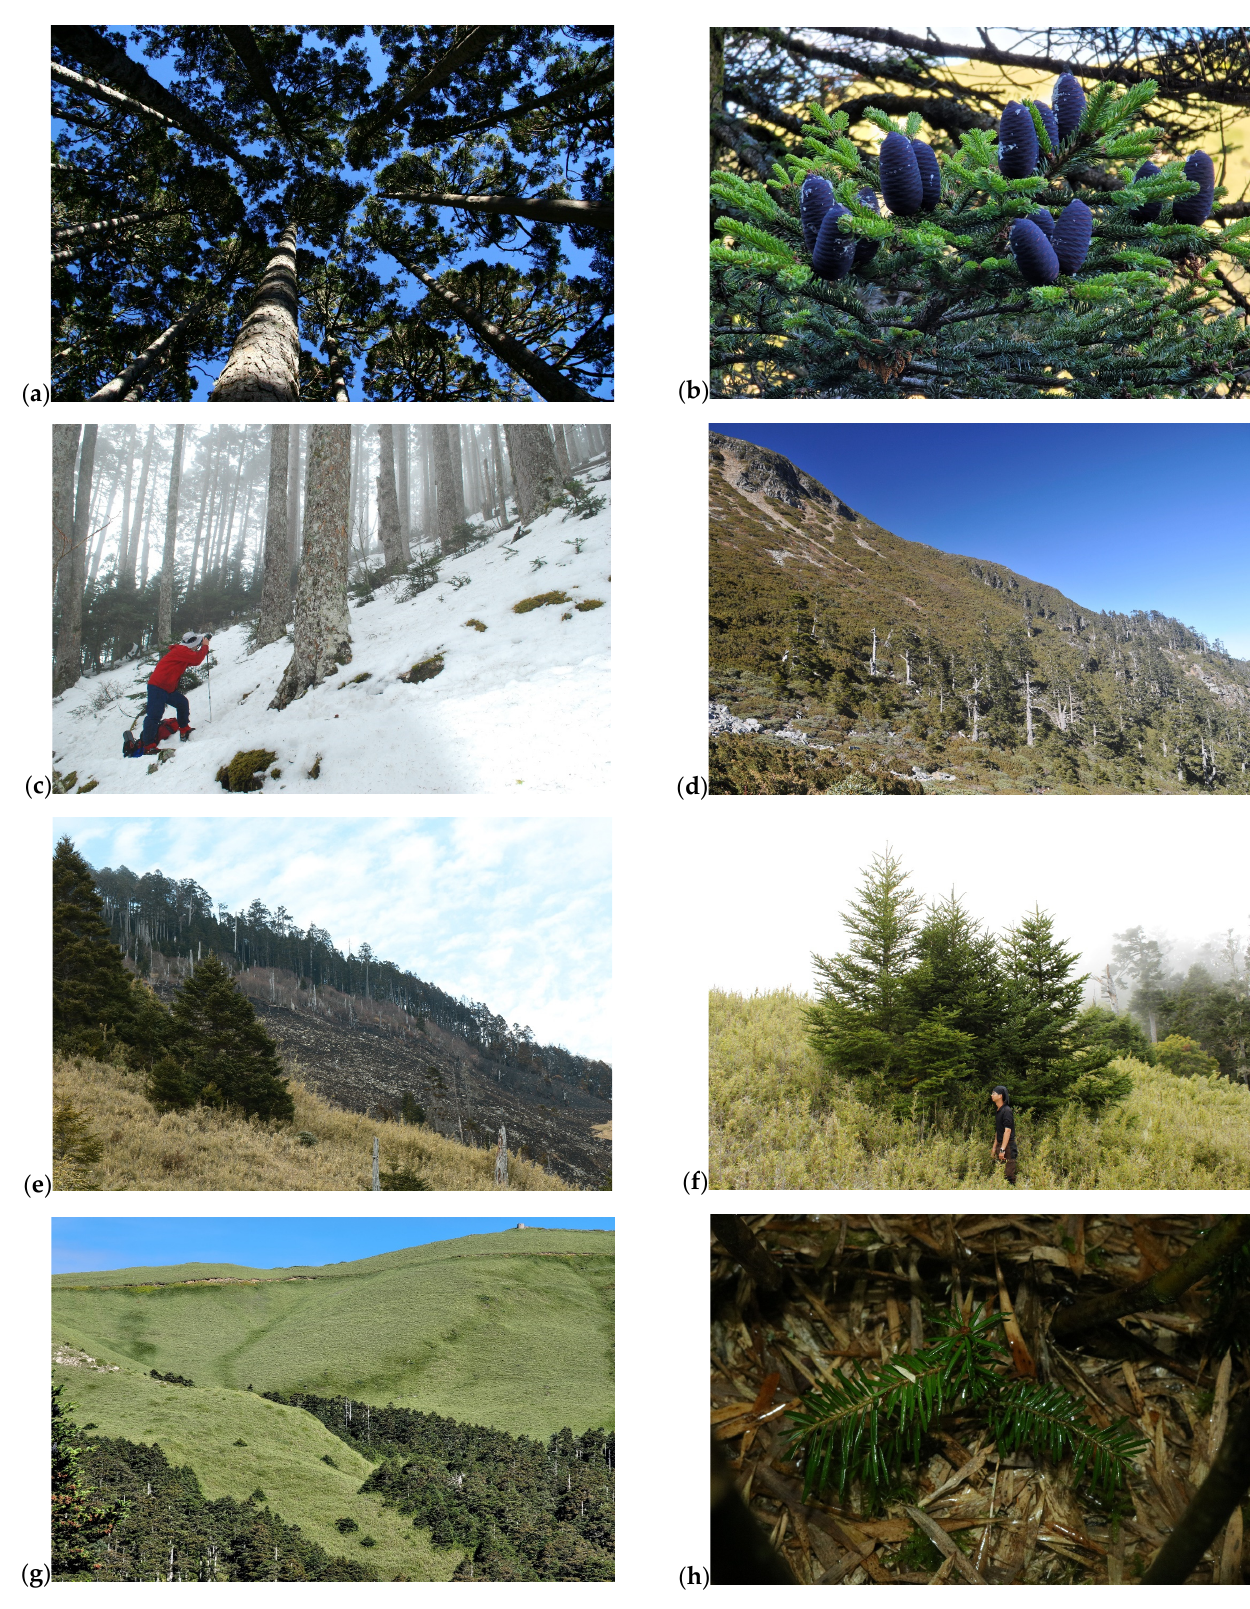
Figure 5. Abies kawakamii forests in Taiwan: ( a ) monodominant species forest, ( b ) cone of A. kawakamii , ( c ) gap regeneration (on the left), ( d ) forest line, ( e ) fire disturbance, ( f ) regeneration after fire disturbance, ( g ) topographic sheltering, and ( h ) seedling in understory, Yushania niitakayamensis .